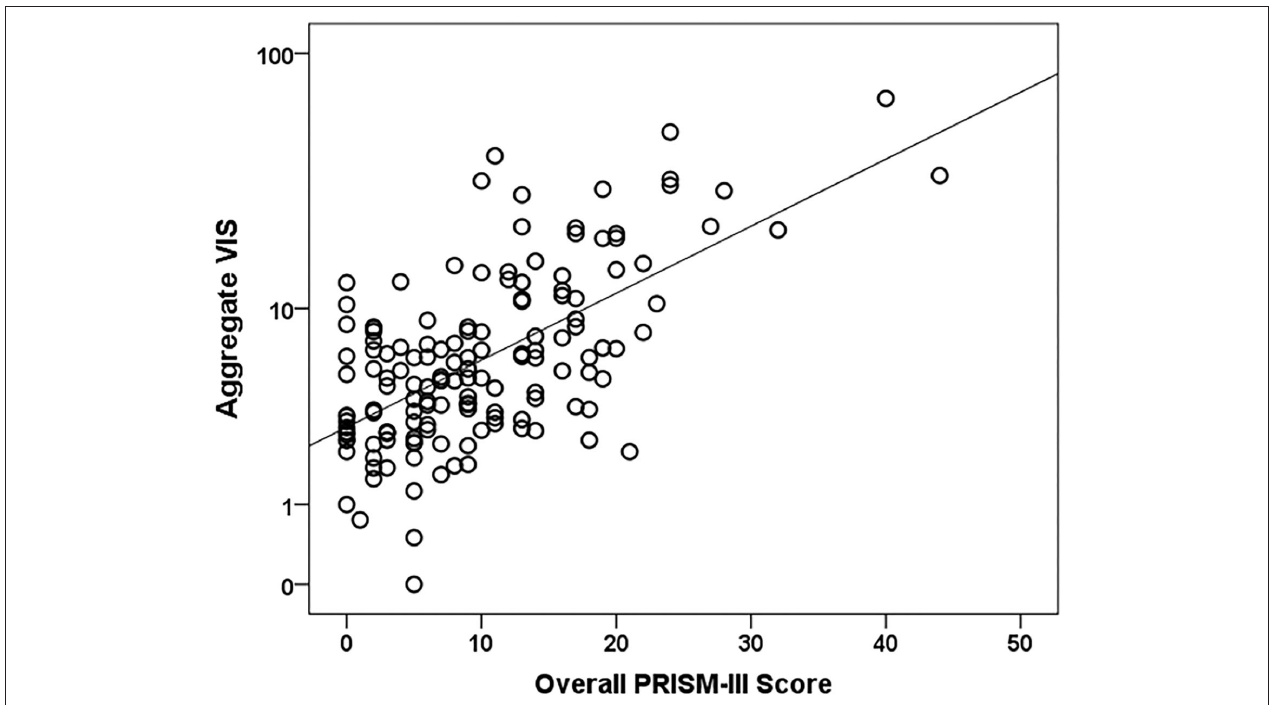
FIGURE 1 | Aggregate VIS vs. PRISM-III severity of illness score scatter plot. N = 156. A Pearson’s correlation test was used to compare the log of Aggregate VIS to PRISM-III scores ( r = 0.6, p -value < 0.0001).